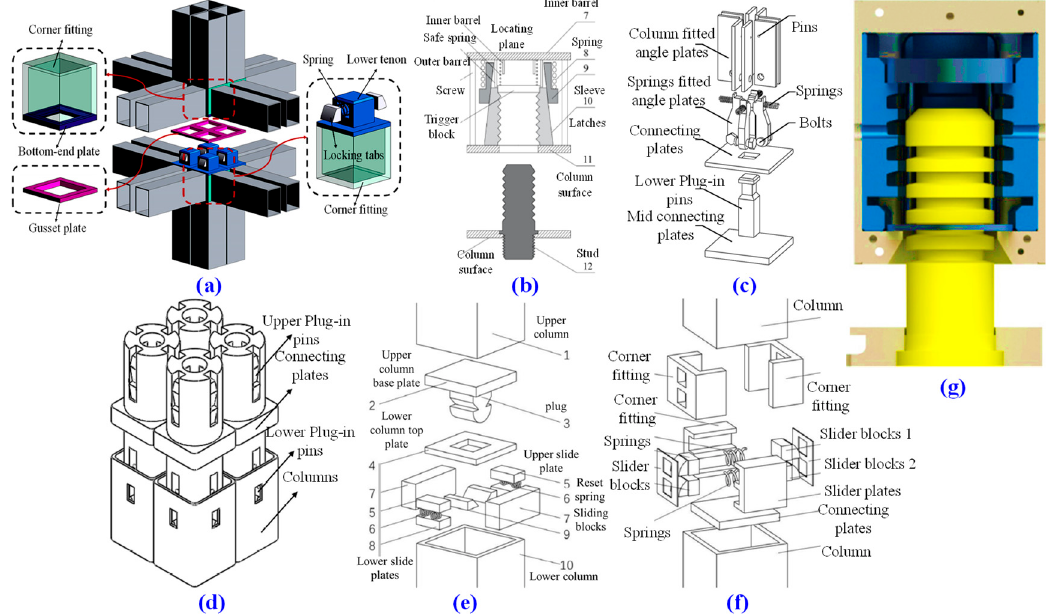
Figure 3. Automatic IMC. ( a ) slider locker tongue [57]; ( b ) self-lock bolt shaft [74]; ( c ) pin plug-in devised [72]; ( d ) circular plug-in devised [73]; ( e ) slider block [71]; ( f ) lock-tongue slider [70]; and ( g ) automated self-lock bolt shaft [75] IMC.